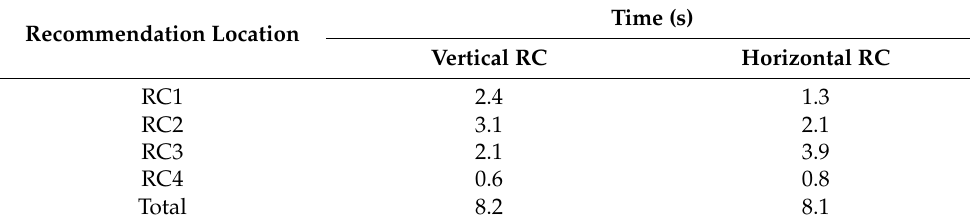
Table 5. Average fixation time (s) for each recommendation location. Recommendation